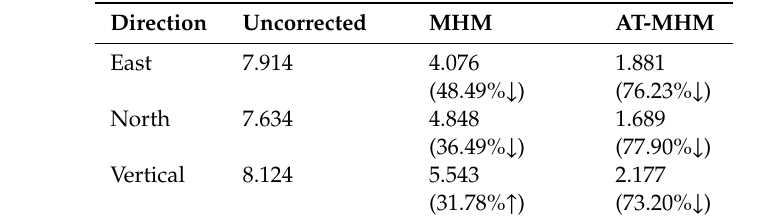
Table 8. The multipath reduction e ff ects of MHM and AT-MHM constructed from DOY 152 on DOY 153. (Unit: meter).